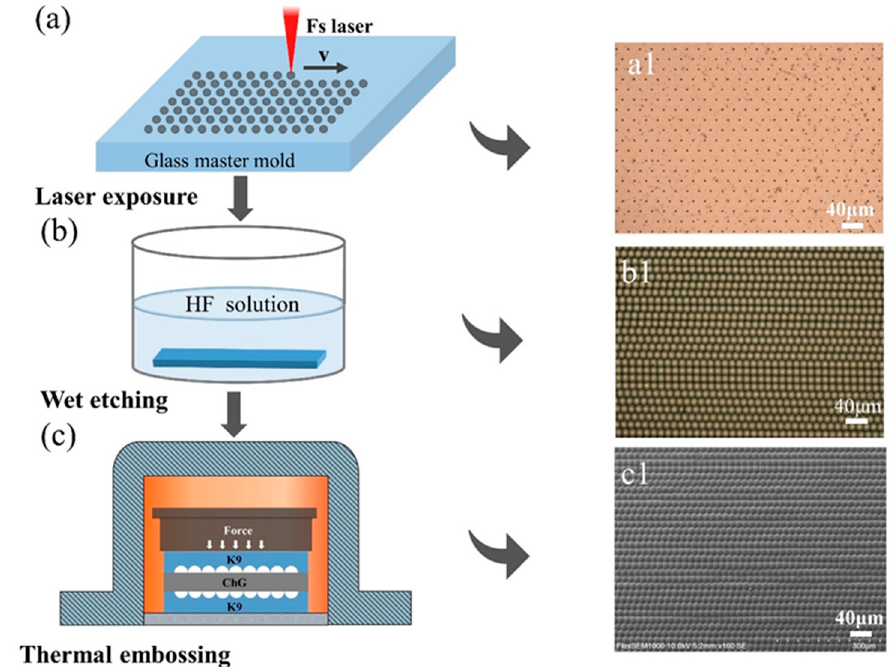
Figure 1. Schematic of the fabrication process. ( a ) Laser-induced BK7 glass modification; ( a1 ) an optical microscope image of the laser-modified area; ( b ) concave microstructures with smooth surfaces were formed by the chemical wet etching process; ( b1 ) an optical microscope image of the irregular concave microstructures; ( c ) the ChG quasi-periodic MLAs were fabricated through a precision molding process; ( c1 ) SEM images of the ChG quasi-periodic MLAs.